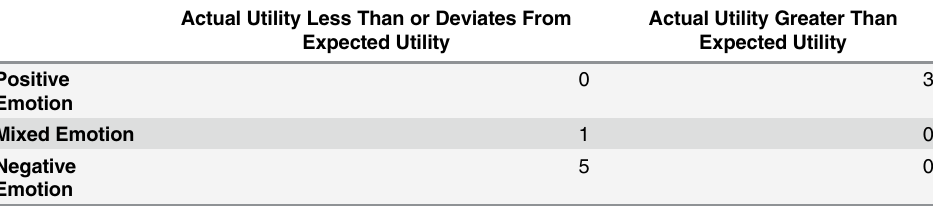
Table 3. Parent Emotion Categories and Actual vs. Expected Utility